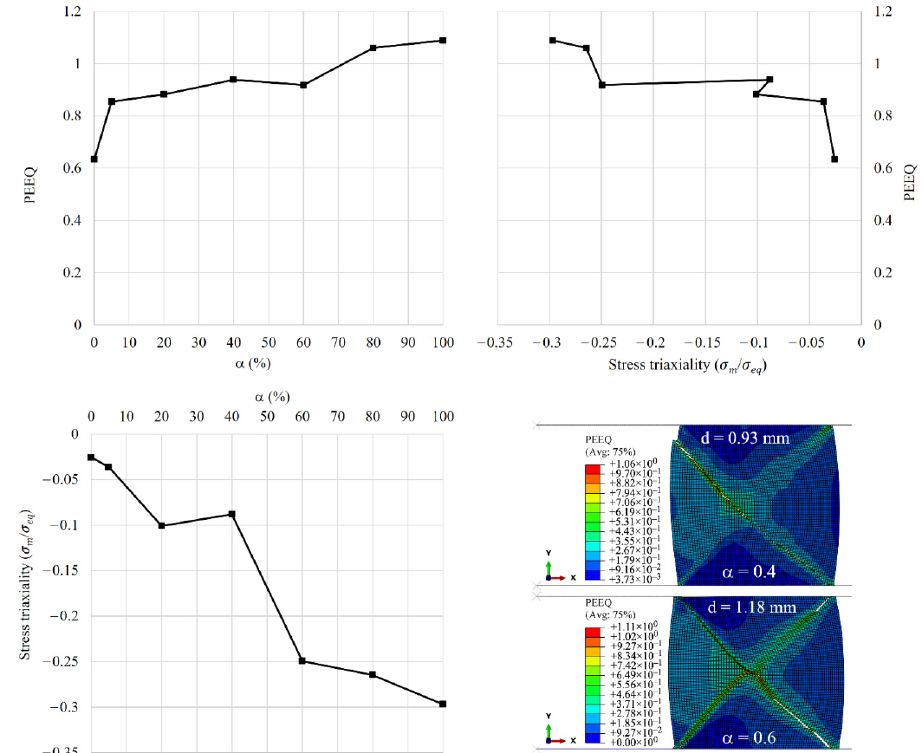
Figure 13. Effect of cladding ratio on stress triaxiality and equivalent plastic strain. The distribution of equivalent plastic strain is shown for the case of cladding ratio of α = 0.4 at the displacement level of d = 0.93 mm, and for the case of cladding ratio of α = 0.6 at the displacement level of d = 1.18 mm .